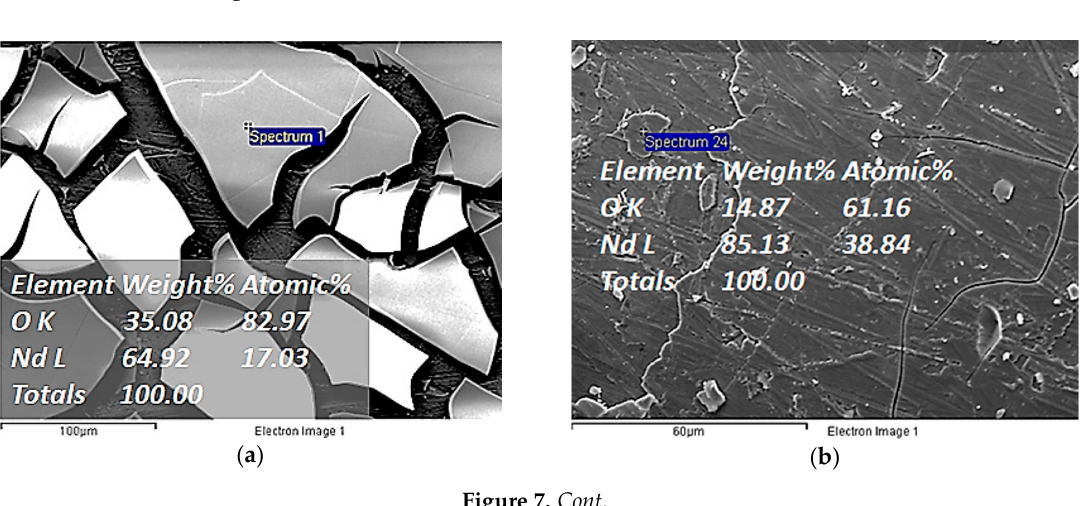
( c ) Figure 7. SEM-EDS analysis of the electrodeposits for the three different concentration solutions ( a ) 0.1 M; ( b ) 0.5 M; ( c ) 1 M. 3.2.4. Temperature Electrolysis was performed at 30 °C, 50 °C, and 70 °C. The electrolysis was realized by imposing current galvanic pulses at − 2 mA for 1 s and − 0.1 μ A for 3 s for a total duration of 5 h, and the solution used for electrolysis was 1 M NdCl 3 in DMSO. DMSO has a boiling point at 189 °C that permits the increase of temperature during electrolysis. Nevertheless, there is an unavoidable evaporation at lower temperatures that could alter the volume and by consequence the concentration of the solution. This is the reason that electrolysis was performed for 5 h when studying the effect of the temperature, instead of 24 h. A 24 h test could have been performed by the use of a condenser, but that would render the set up rather difficult to install inside the glove box. The masses of the electrodeposits are presented on Table 3. Table 3. The mass of the deposit (in mg) produced at the three tested temperatures (in °C).